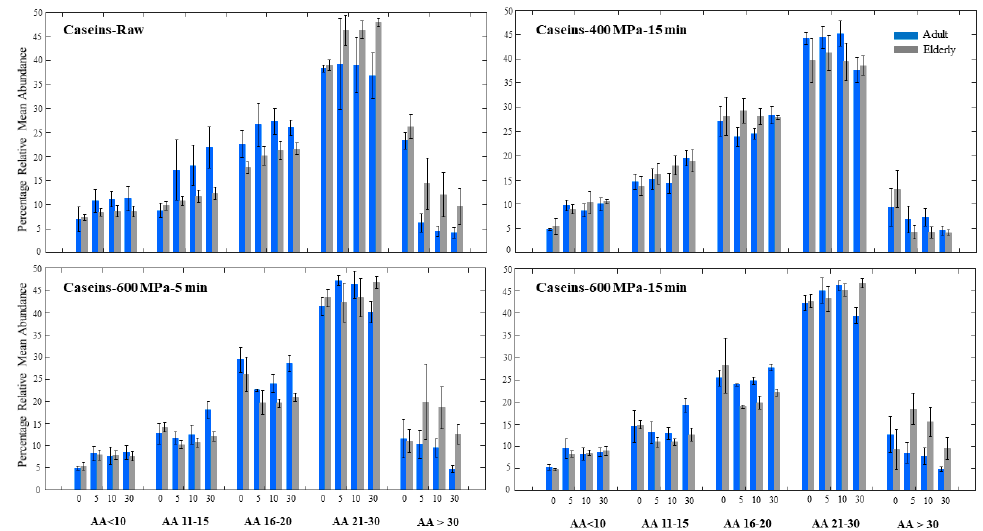
Figure 3. Relative mean abundance (%) of peptides originated from caseins ( α s 1 -casein, α s 2 -casein, β -casein, and κ -casein) after 0, 5, 10, and 30 min gastric digestion of raw milk and various HPP treated milks using the in vitro adult and elderly models. The peptides are categorized based on number of AA into five groups. The bars are the average of two independent replicates, and the error bars represent the standard deviations.